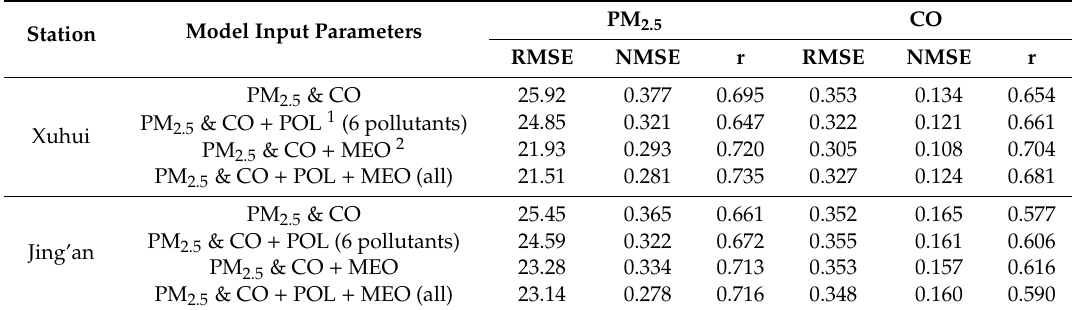
Table 2. The model performances of Seq2Seq with weekly periodicity under di ff erent input parameters.